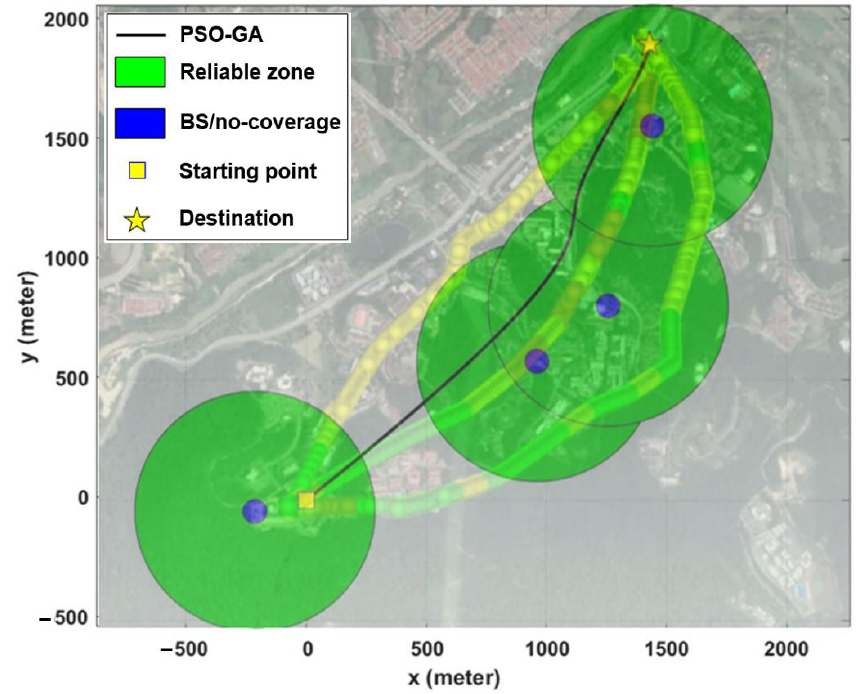
Figure 20. Comparison of path planning optimization simulation results against aerial drive test measurements.